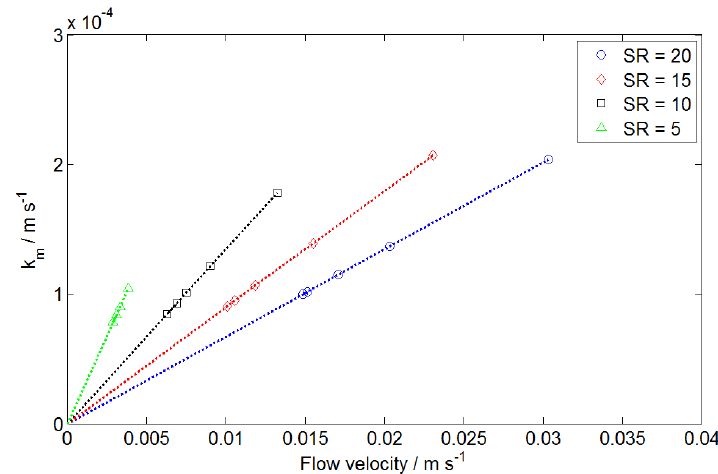
Figure 4. Calculated mass transfer coefficient is plotted vs. mean flow velocity at different SR